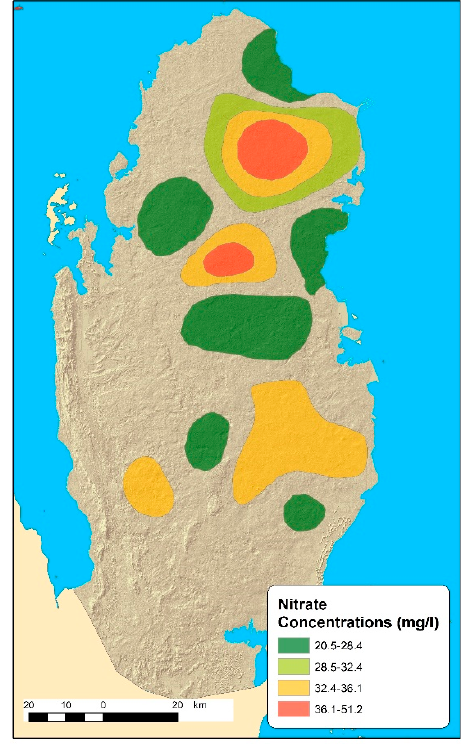
Figure 8. Major nitrate contamination areas in Qatar (after Reference